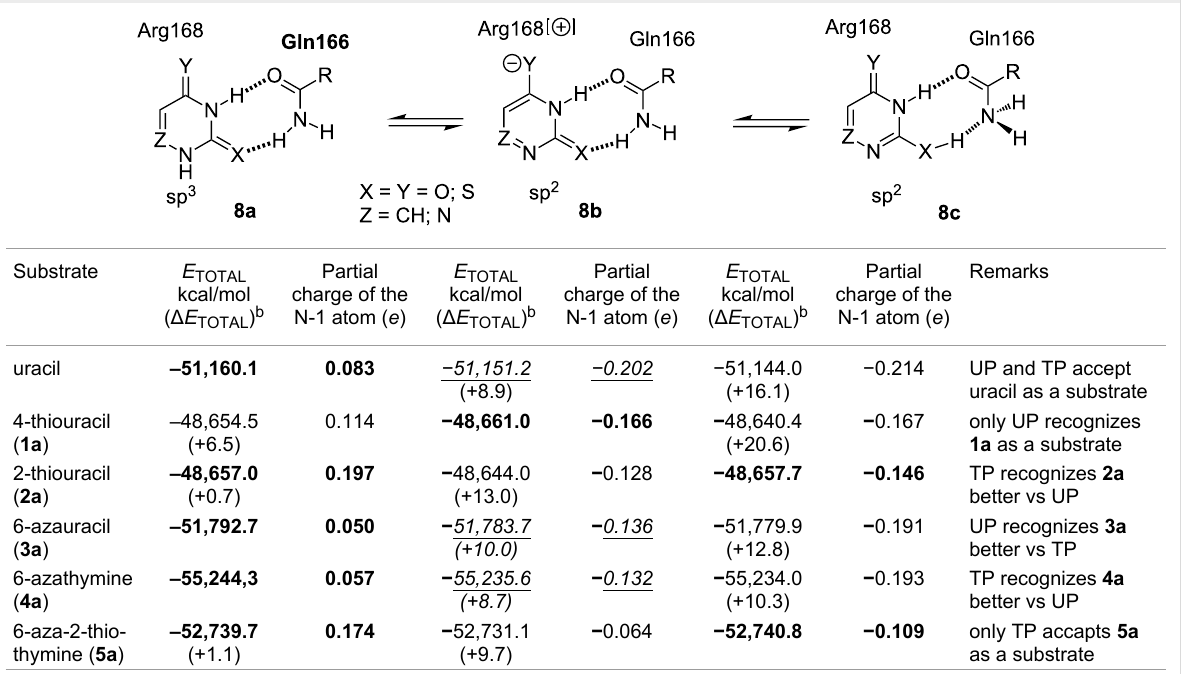
Table 1: Geometry optimized supposed tautomeric structures of uracil and bases 1a – 5a at E. coli UP catalytic site with sp 3 and sp 2 hybridized N-1 nitrogen atoms (thermodynamically stable tautomers are highlighted in boldface, and the more stable N-1 sp 2 structures are in italics and under- lined) a